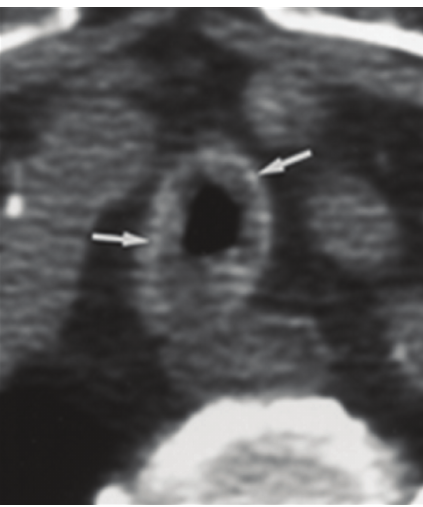
Figure 1: CT scan with amyloid deposits narrowing the tracheal diameter.